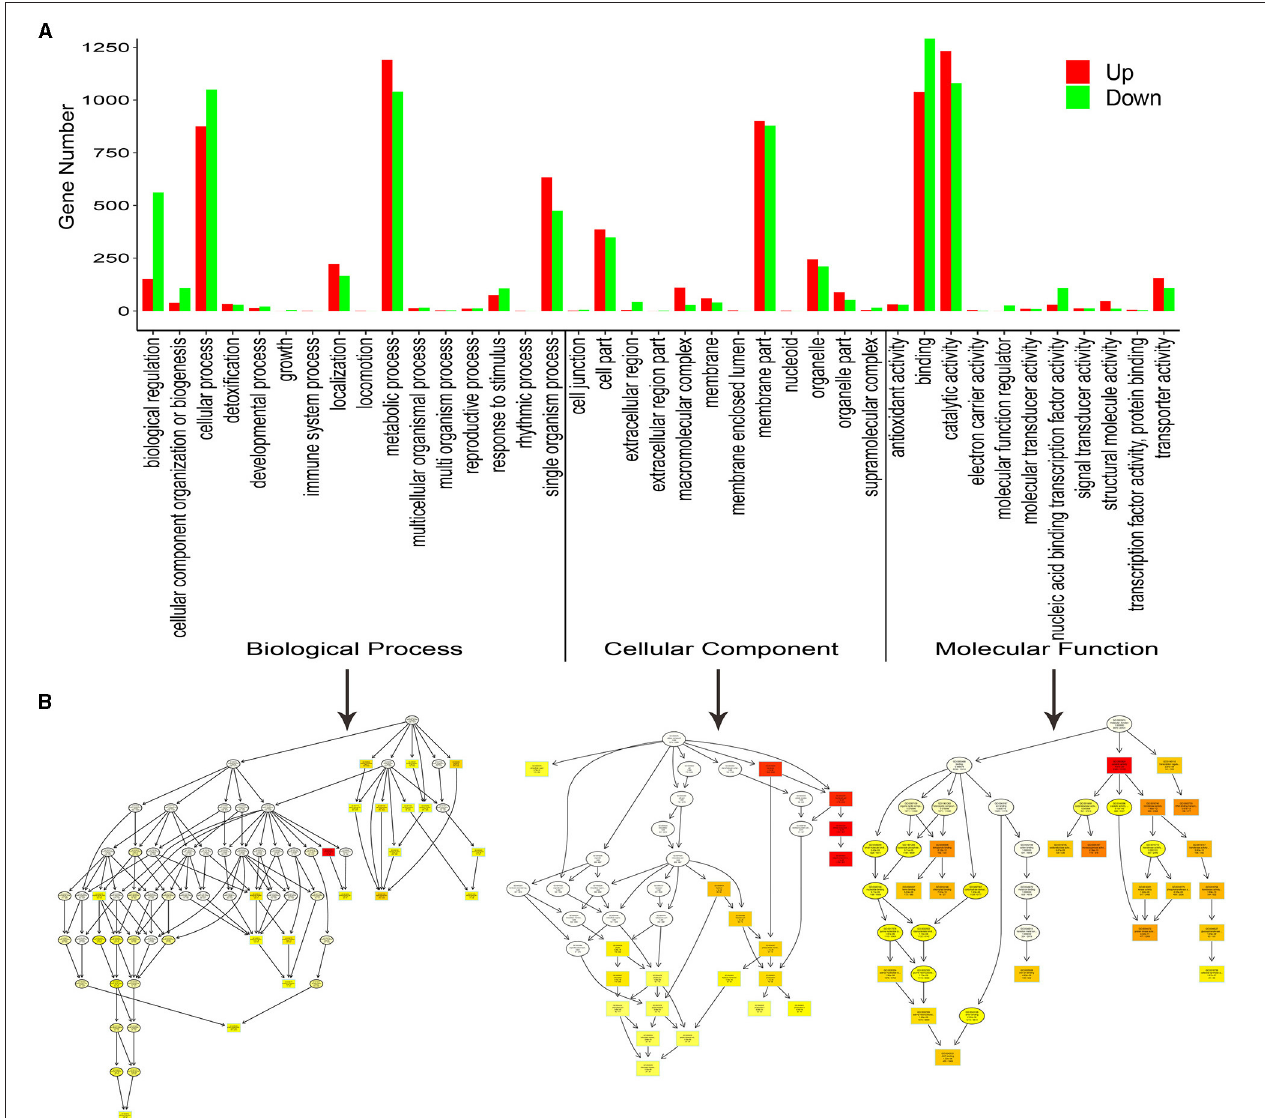
FIGURE 3 | Functional GO and Kyoto Encyclopedia of Genes and Genomes (KEGG) pathway classification of differentially expressed genes. (A) Enriched GO terms are shown on the x-axis, and the numbers of the up- and down-regulated differentially expressed genes are shown on the y-axis. (B) Directed acyclic graphs of three main categories are displayed in thumbnail view. The nodes are color-based on the q -value, and a darker color indicates a higher confidence level. The GO terms are presented at the horizontal node